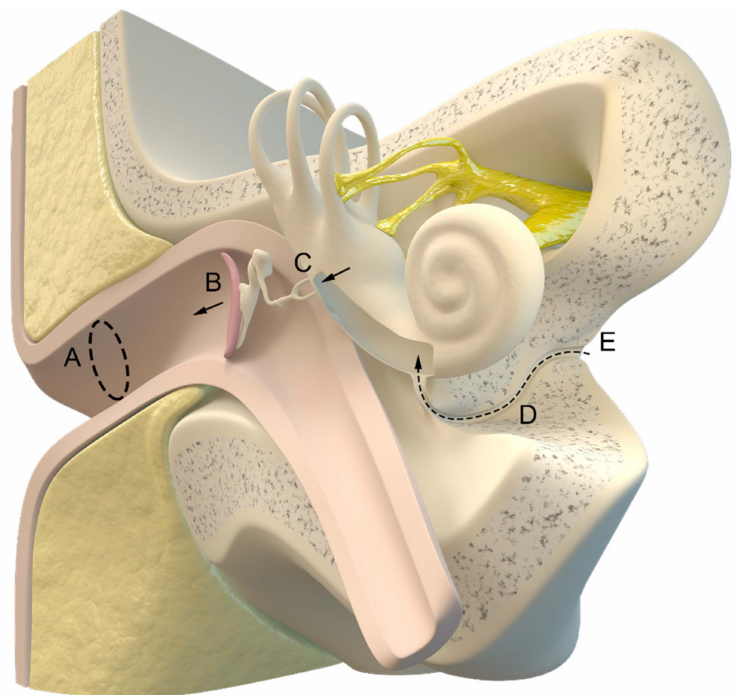
Figure 5. Illustration of the inner and outer ear with the cochlear aqueduct (D) connecting the intracranial cerebrospinal fluid (E) and cochlea. (A) ear canal, (B) tympanic membrane, (C) auditory ossicles. Illustration made by J.